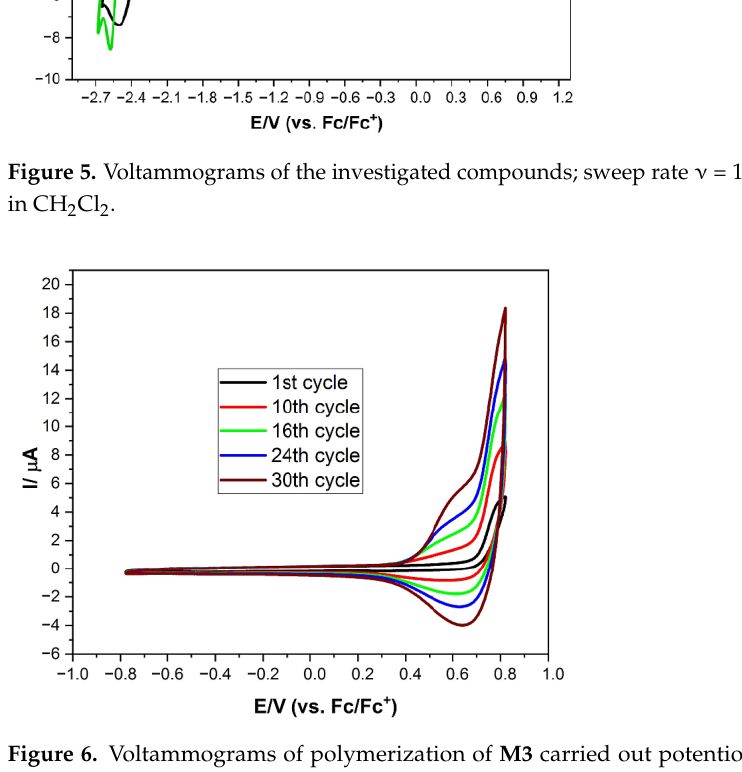
Figure 7. Voltammograms of poly - M3 (polymerization carried out potentiodynamically with upper potential as high as 0.82 V) with sweep rate ν = 100 mV/s, 0.1 M Bu 4 NPF 6 in CH 2 Cl 2 .